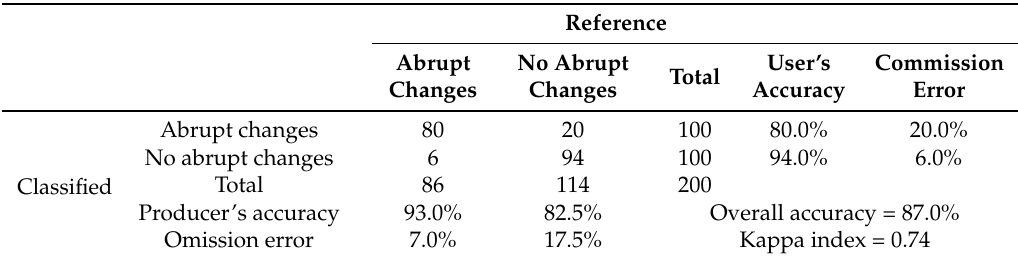
Table 4. Error matrix for detecting abrupt land cover